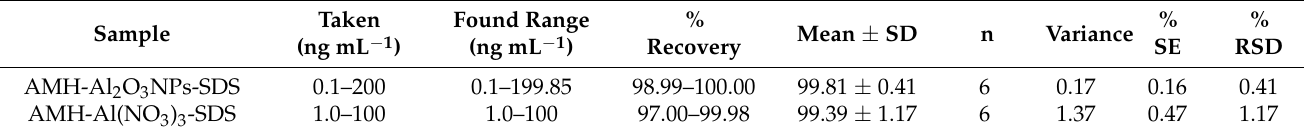
Figure 10. ( a ) Possible pathway for the interaction between AMH and Al(NO 3 ) 3 and ( b ) the distribution of the investigated drug on the surface of Al 2 O 3 NPs. Table 5. Results of AMH assay using the suggested spectrofluorometric Al 2 O 3 NPs-SDS and AMH- Al(NO 3 ) 3 -SDS systems.